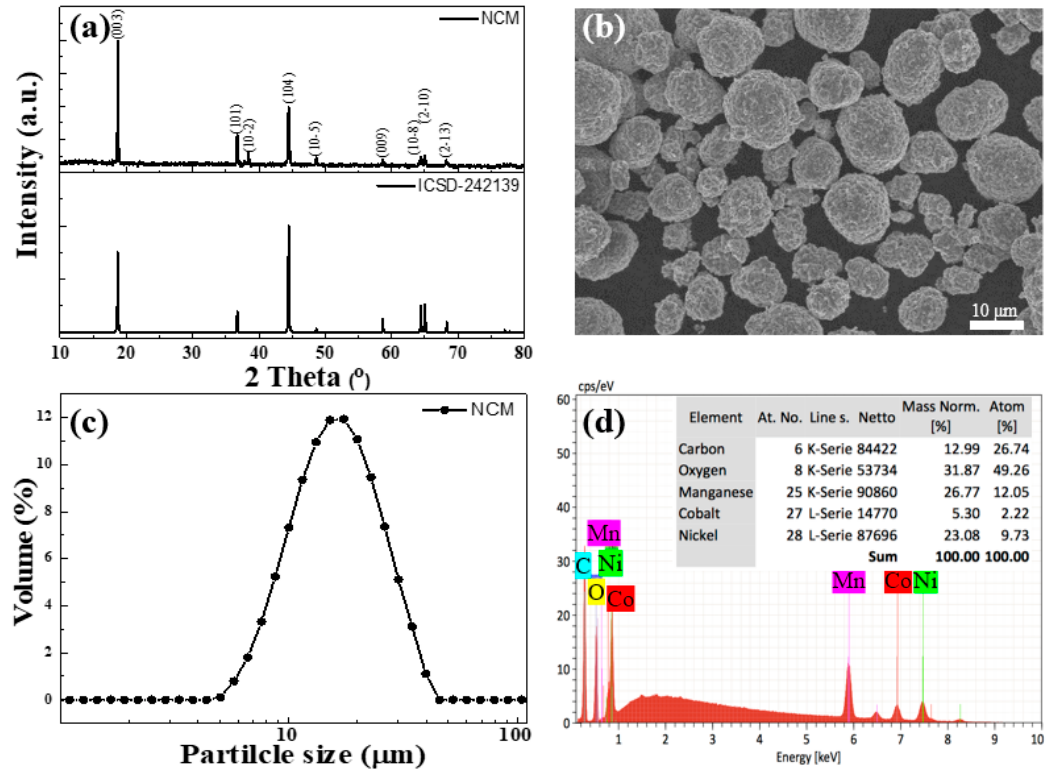
Figure 1. ( a ) X-ray diffraction (XRD) pattern of LiNi0.5Co0.2Mn0.3O2 (NCM), ( b ) scanning electron microscopy (SEM) image of NCM, ( c ) particle size distribution of NCM and ( d ) energy dispersive X-ray spectroscopy (EDS) image of NCM.